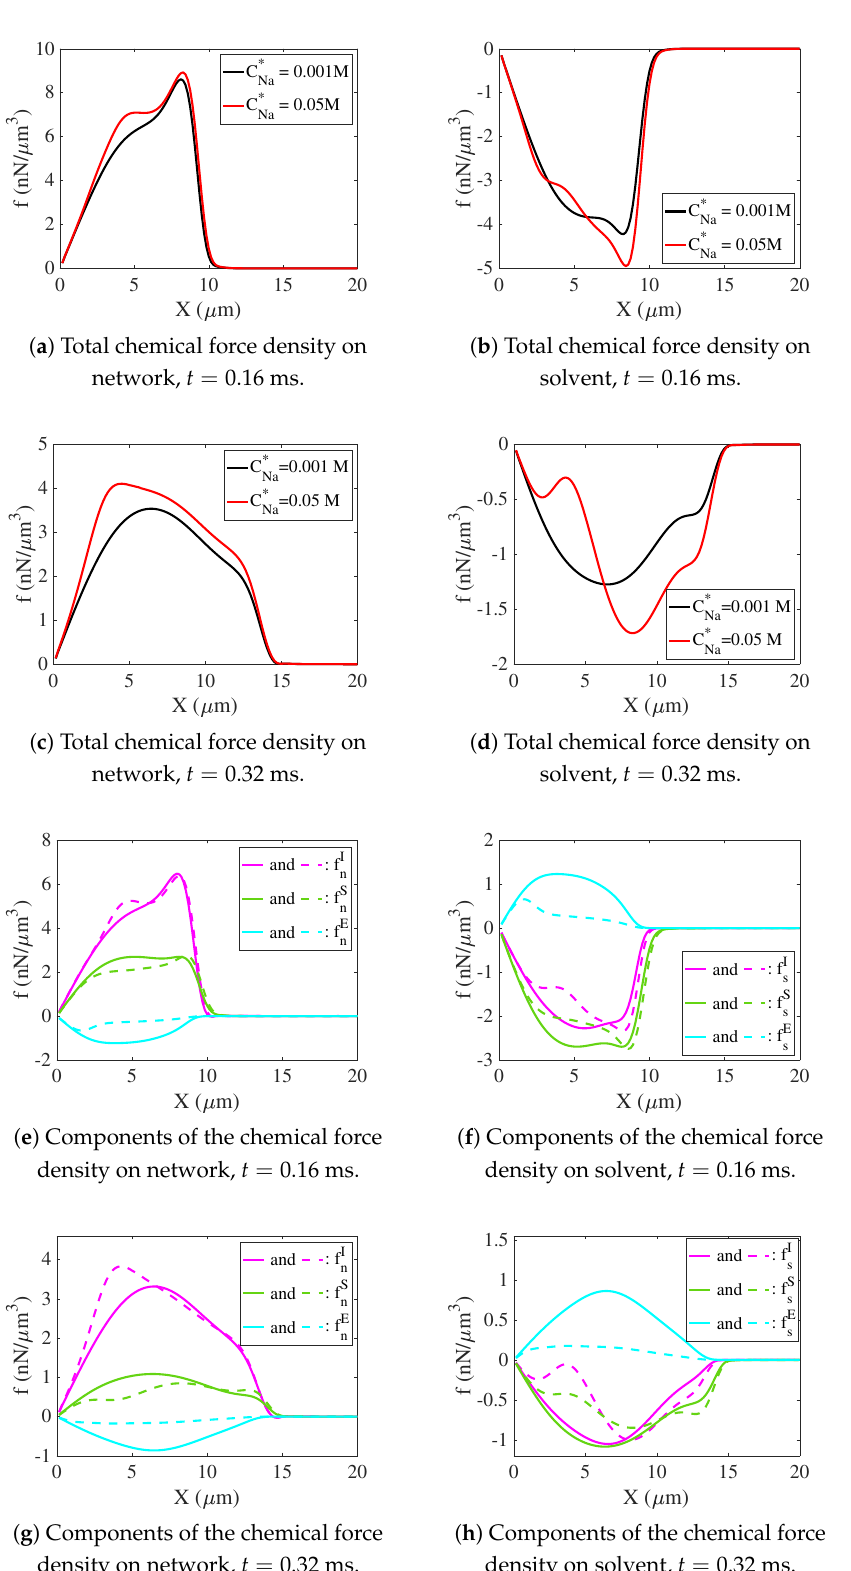
Figure 6. Network and solvent chemical force densities along the positive x -axis. Total chemical force densities on network and solvent at ( a , b ) t = 0.16 ms and ( c , d ) t = 0.32 ms. Components of the network and solvent chemical force densities for C ∗ at ( e , f ) t = 0.16 ms and ( g , h ) t = 0.32